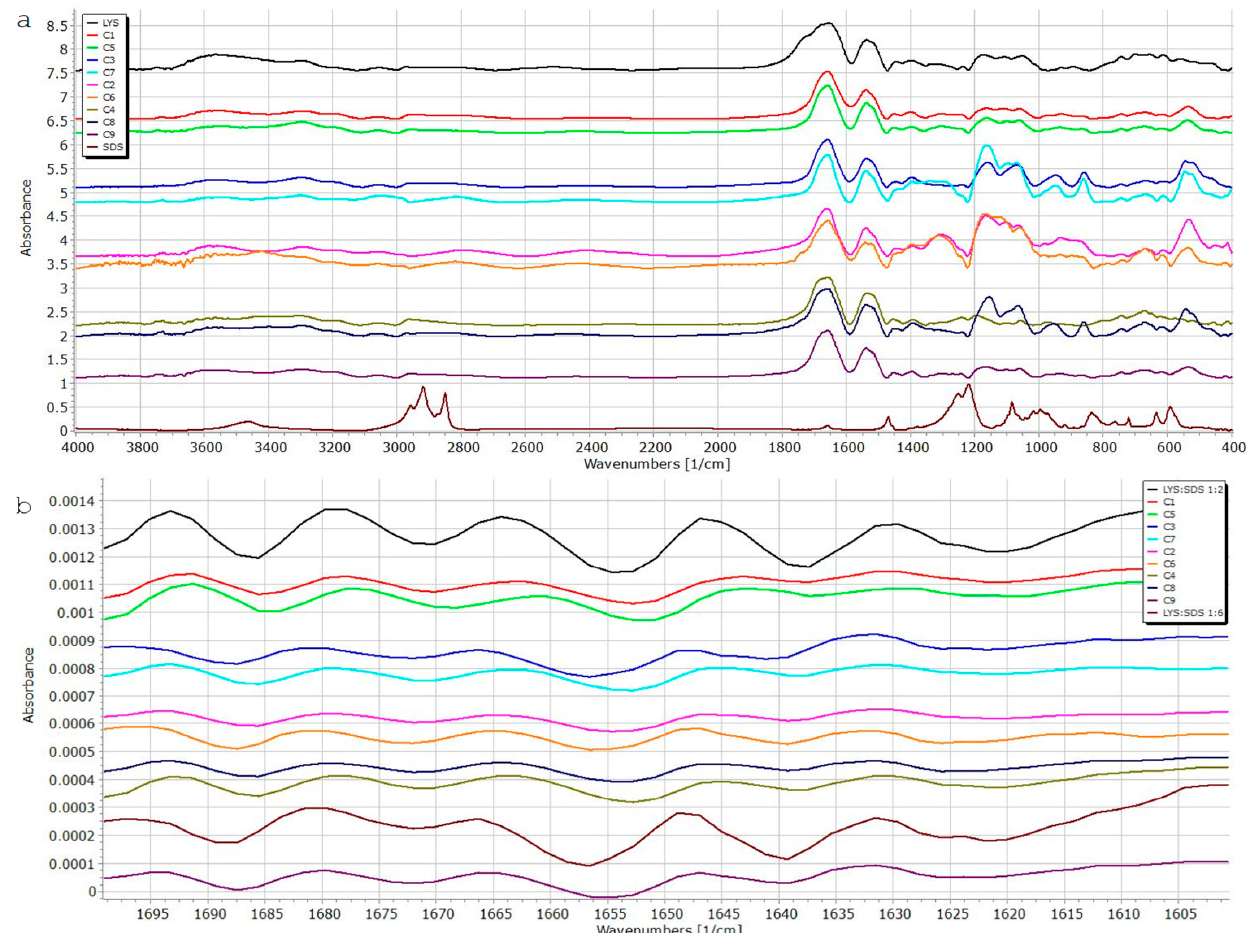
Figure 5. FT-IR spectra of the LYS:SDS complexes ( a ) and the second derivative of the amide I bands ( b ).